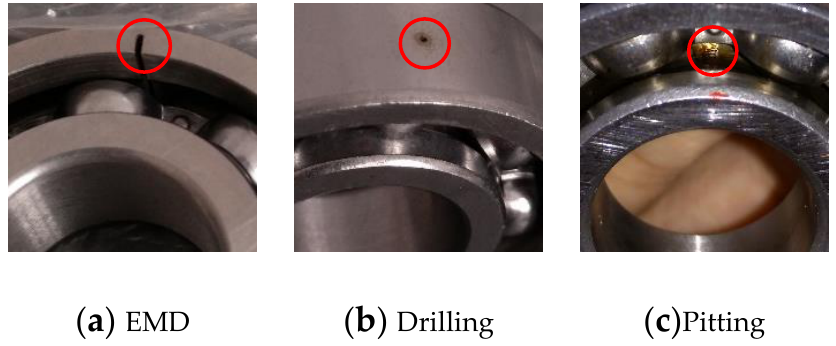
Figure 7. Different fault in testing bearings.